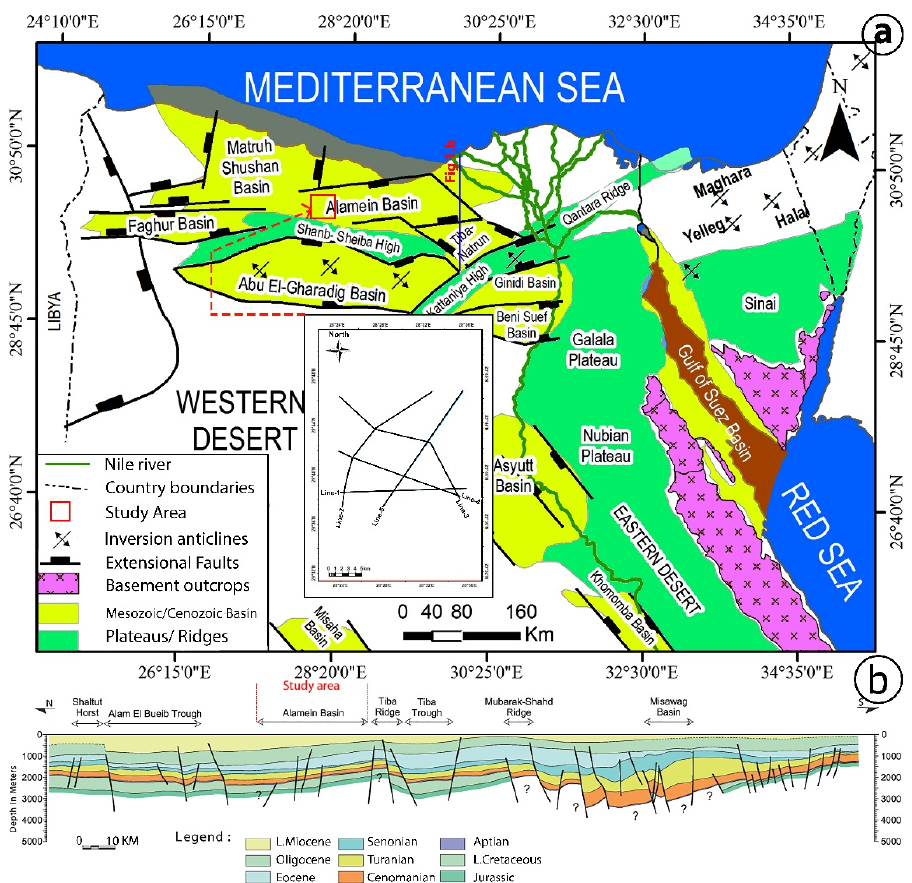
Figure 1. ( a ) Regional structural elements of the study area (modified from the work of Elmahdy, Tarabees, Bakr and Farag [20]) with ( b ) regional geological cross-section (modified from the work of Moretti, Kerdraon, Rodrigo, Huerta, Griso, Sami, Said and Ali